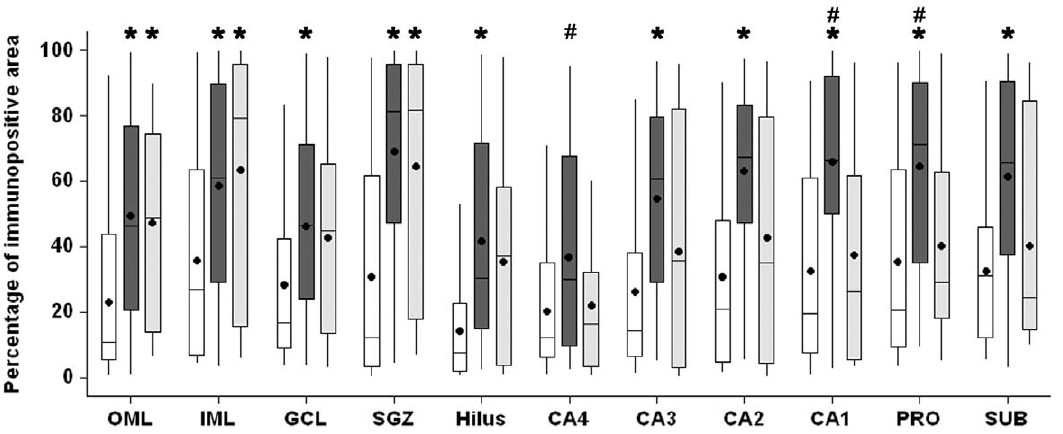
Figure 10. MT-I/II immunopositive area in hippocampal subfields of Ctrl, MTLE and TLE-TD groups. Compared to Ctrl (white boxplots), TLE groups had higher MT-I/II immunopositive area (showed as percentage of immunopositive area) in outer molecular layer (OML), inner molecular layer (IML) and subgranule zone (SGZ) (p , 0.01). MTLE (dark gray boxplots) had increased MT-I/II immunoreactivity in granule cell layer (GCL), hilus, CA4, CA3, CA2, CA1, prosubiculum (PRO) and subiculum (SUB) (p , 0.05), compared to Ctrl, and also in CA1 when compared to TLE-TD (p , 0.001). The